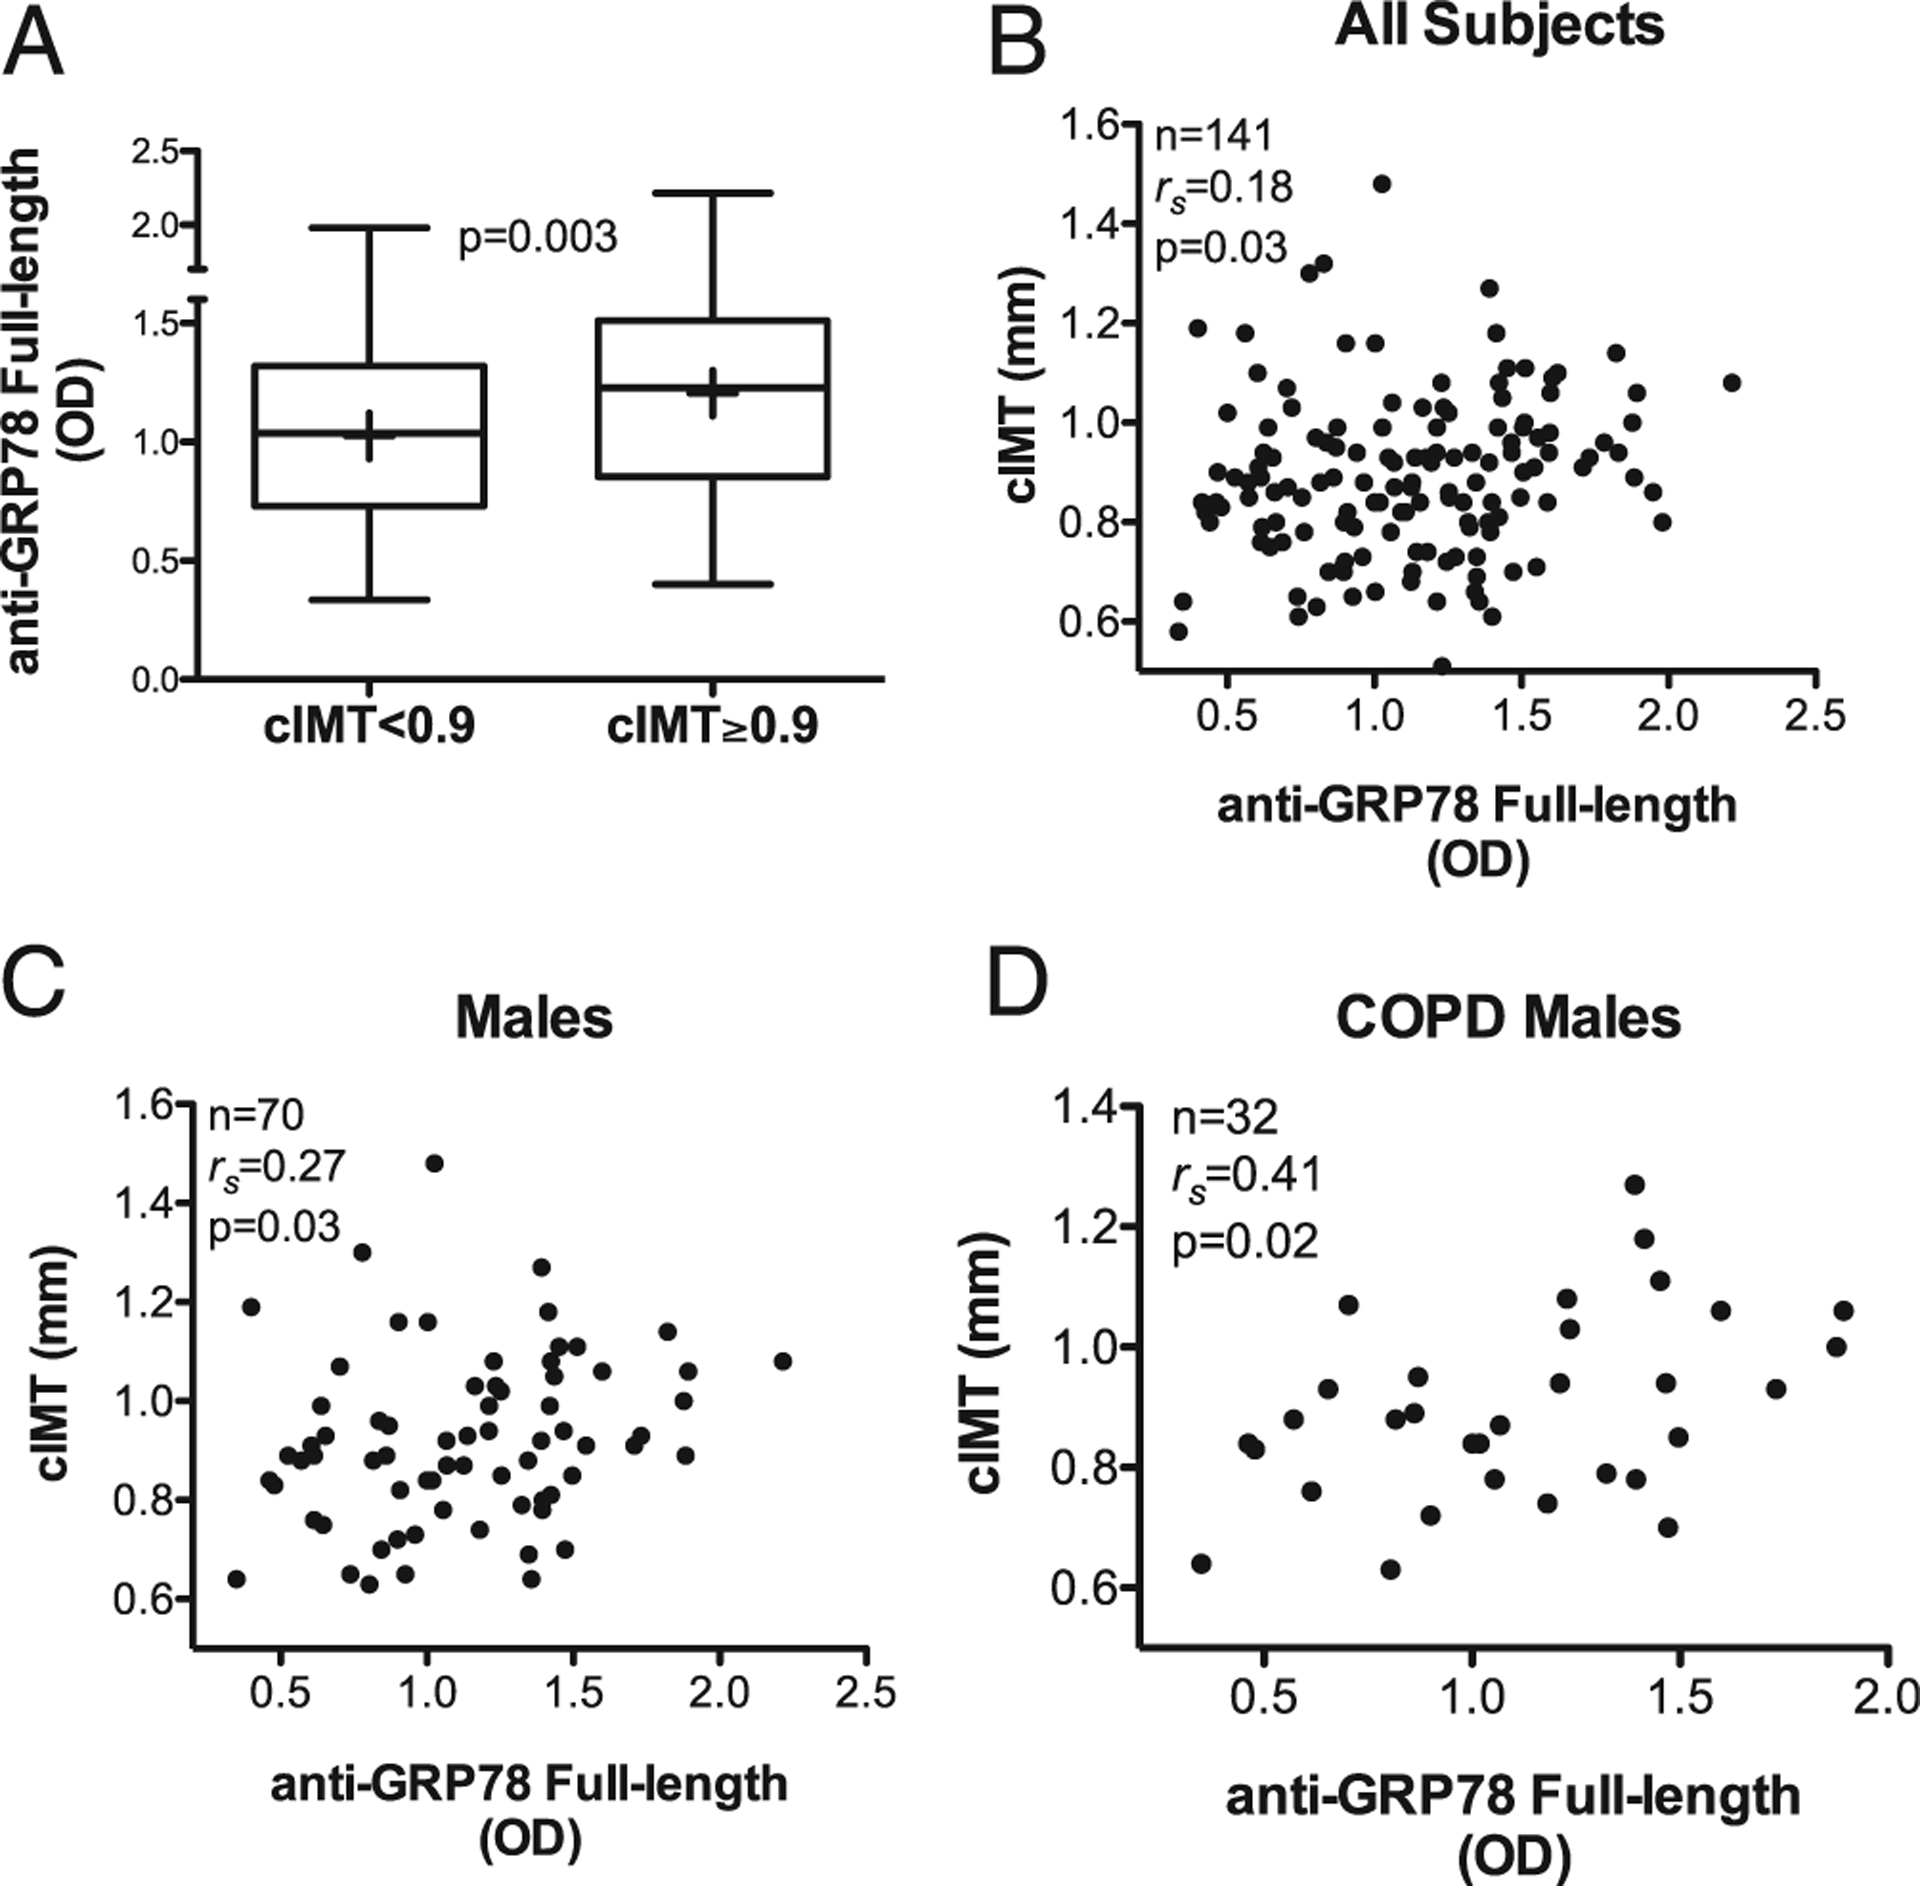
Autoantibodies to full-length GRP78 protein in the study cohort were associated with carotid atherosclerosis.(A) Anti-GRP78 autoantibody levels (as ODs measured by ELISA) were greater in the subpopulation with abnormal cIMT, defined by cIMT ≥0.9 mm, compared with those with normal cIMT values. The lowest, second lowest, middle, second highest, and highest lines represent the 10th, 25th, median, 75th, and 90th percentiles, respectively. Means are denoted by the plus sign (+). (B) Correlation between the ELISA OD for autoantibodies with specificities to full-length GRP78 and cIMT in the aggregate study population. (C) Correlation between the levels of autoantibodies to full-length GRP78 and cIMT in male subjects. (D) Correlation between the levels of autoantibodies to full-length GRP78 and cIMT in males with COPD.